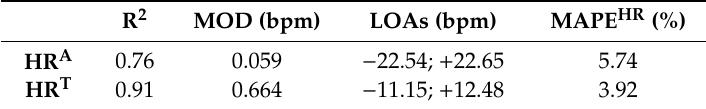
Table 3. Bland-Altman of beat-by-beat analysis.